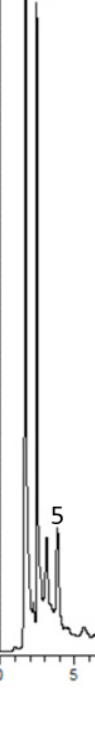
Figure 1. HPLC-UV chromatogram of P. perfoliatus extract. Table 1. Identified compounds from P. perfoliatus extract.